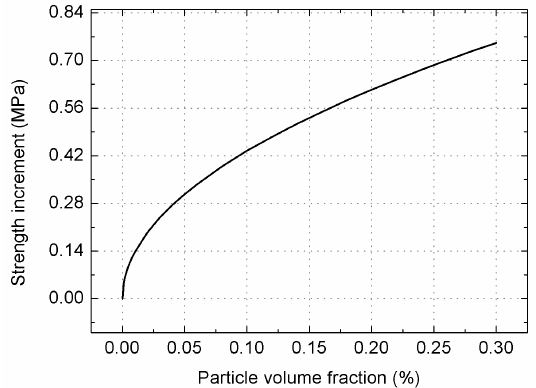
Figure 9. Dependence of the yield strength based on MSL model on the reinforcement volume fraction.